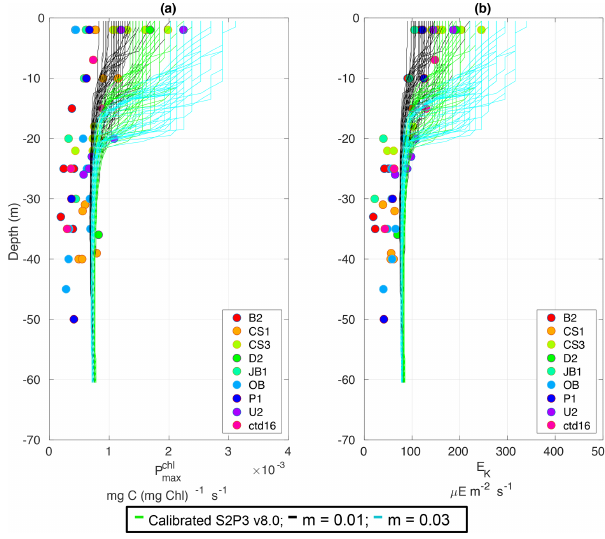
Figure C6. Observations from the cruises CD173 and JR98 in dif- ferent locations in the Celtic Sea, including the calibrated S2P3 v8.0 model (green lines), experiments m = 0 . 01 (black lines) and m = 0 . 03 (cyan lines) for (a) chlorophyll a specific maximum light- saturated photosynthesis rate ( P Chl max ) and (b) light saturation param- eter ( E k ).